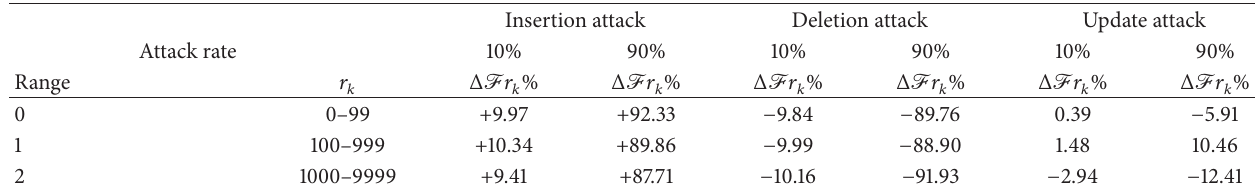
Table 17: Characterization of malicious data modifications on range of data